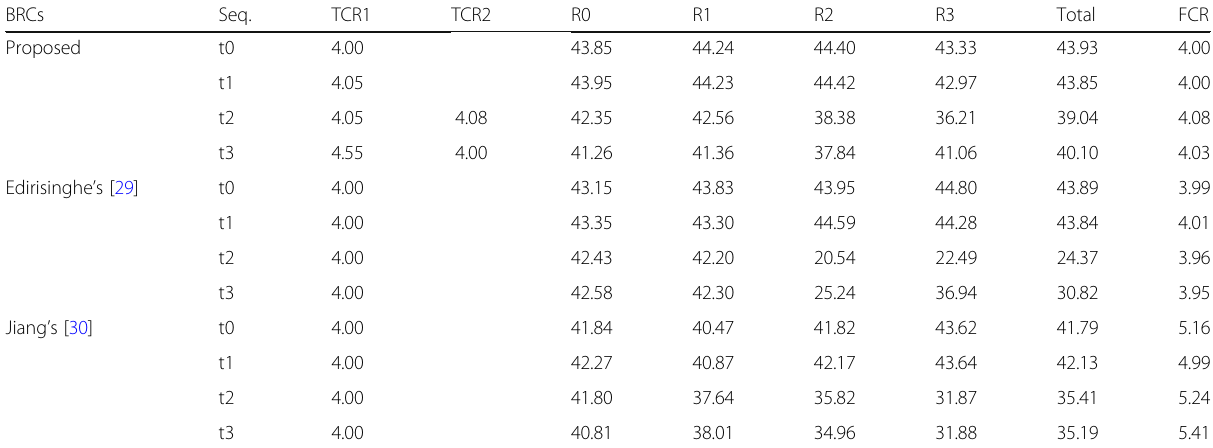
Table 6 BRC results for testing image sequences